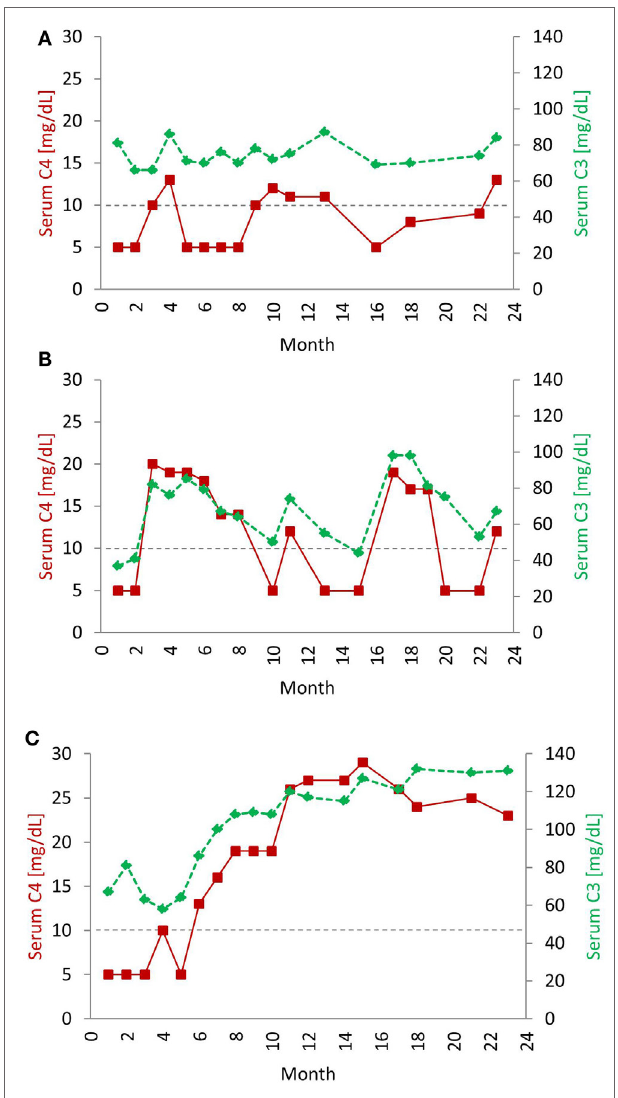
FiGURe 2 | Typical serial serum protein profiles of complement C4 and C3 in human SLe patients . Serum C4 (red, solid line) and C3 (green, dashed line) protein levels tend to go up and down together in most SLE patients. The horizontal dotted line indicates the low level of serum C4 ( < 10 mg/dL), below which usually requires clinical attention. The profiles shown are taken from three individual patients over a 24-month period and represent three common profiles typically observed in SLE patients. In the first profile (A) , levels of C4 and C3 were chronically low. In some patients, even if C3 levels rose to normal range, C4 levels remained low. Patients with this profile are often characterized by low copy-number of C4 genes. (B) The second profile had frequent and parallel fluctuations of serum C3 and C4. Patients with this profile had active disease, and low C3 and low C4 roughly correlated with disease activity. In the third profile (C) , C4 and C3 protein levels stayed in the normal range most of the time, except at the time of diagnosis and during a disease relapse. Patients with this profile had relatively inactive disease. Patients with the second and third profiles have normal gene copy- number of total C4 but may have a heterozygous deficiency of C4A [modified from Reference